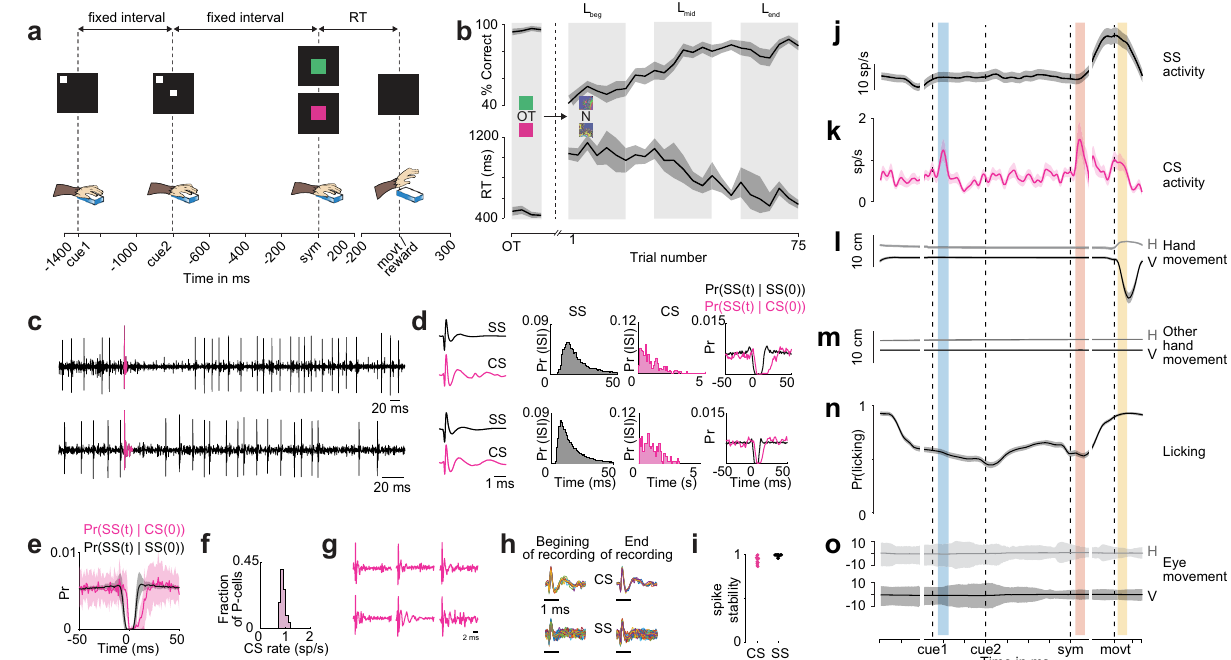
Fig. 1 Experimental task, behavior, and cerebellar electrophysiology. a Schematic of a trial structure of the task. b Mean learning curve (top) and mean reaction time (bottom) from all sessions. n = 25 sessions. c Two representative raw neural signals from non-human primate B (top) and non-human primate S (bottom) highlighting the CS in pink. d Top panel: left: mean SS and CS waveforms from the cell shown in top panel of c . Middle: distribution of SS and CS interspike intervals (ISI) for the same cell. Right: conditional probabilities of spike timings. Bottom panel: same as the top panel but for cell shown bottom panel of c . e Average conditional probabilities of spike timings from all P-cells. n = 25 P-cells. f Population CS rate histogram. n = 25 P-cells. g Six representative CS waveforms from different P-cells showing the diversity in duration of CS and number of spikelet. h CS and SS waveforms from a representative recording at the beginning and end of recording. i Correlation of CS waveforms (left) and SS waveforms (right) between the beginning and the end of recording for each neuron used in this study. Correlations close to one indicates stability of recorded waveforms through time. n = 25 P-cells. j Mean spike density function of population SS responses in the OT condition. Blue shaded region indicates the cue epoch, orange, symbol epoch and yellow, reward epoch. n = 25 P-cells. k Mean spike density function of population CS responses in the OT condition. n = 25 P-cells. l Mean horizontal (gray) and vertical (black) positions of the responding hand. n = 25 sessions. m Mean horizontal (gray) and vertical (black) positions of the non-responding hand. n = 25 sessions. n Mean licking activity. n = 25 sessions. o Mean horizontal (gray) and vertical (black) eye positions. n = 25 sessions. Data shown as mean ± s.e.m. Source data are provided as a Source Data fi